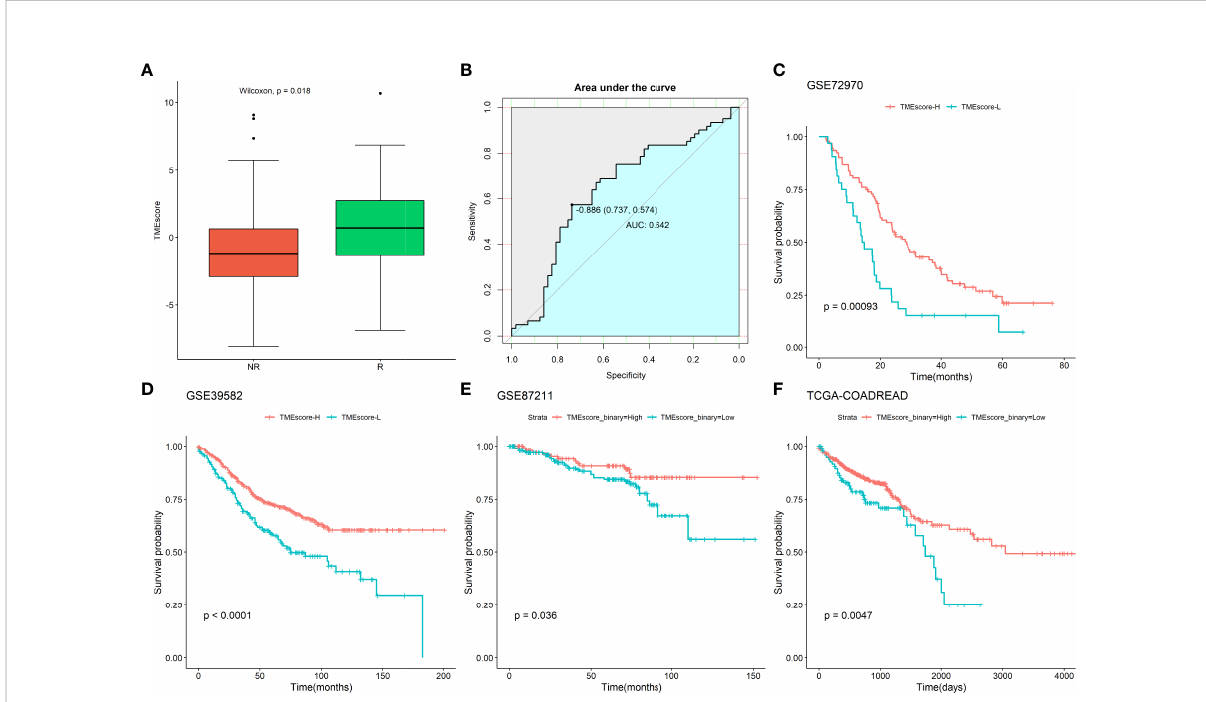
FIGURE 3 Association of TMEscore with chemotherapy response and survival in CRC patients. (A) Comparison of TMEscore between response and non- response to the chemotherapy; (B) ROC of the TMEscore in predicting the response to chemotherapy; Association of TMEscore with survival of CRC patients underwent chemotherapy in (C) GSE72970 dataset; (D) GSE39582 dataset; (E) GSE87211 dataset; (F) TCGA-CORDREAD